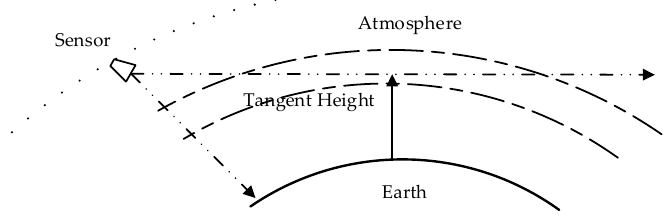
Figure 1. Schematic diagram of limb sounding.